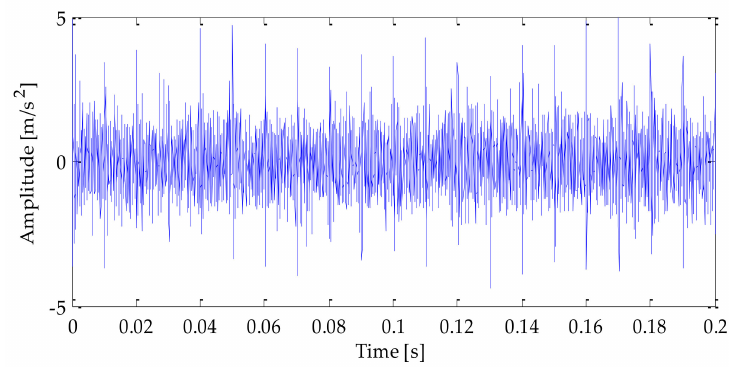
Figure 15. EEMD–RobustICAnoise-reduction results.